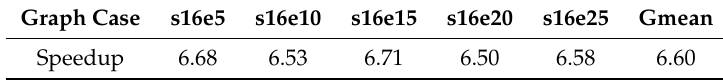
Figure 18. Comparison of the performance between baseline and CGAcc on vertexes. Table 5. Speedup of CGAcc in the sensitivity test on